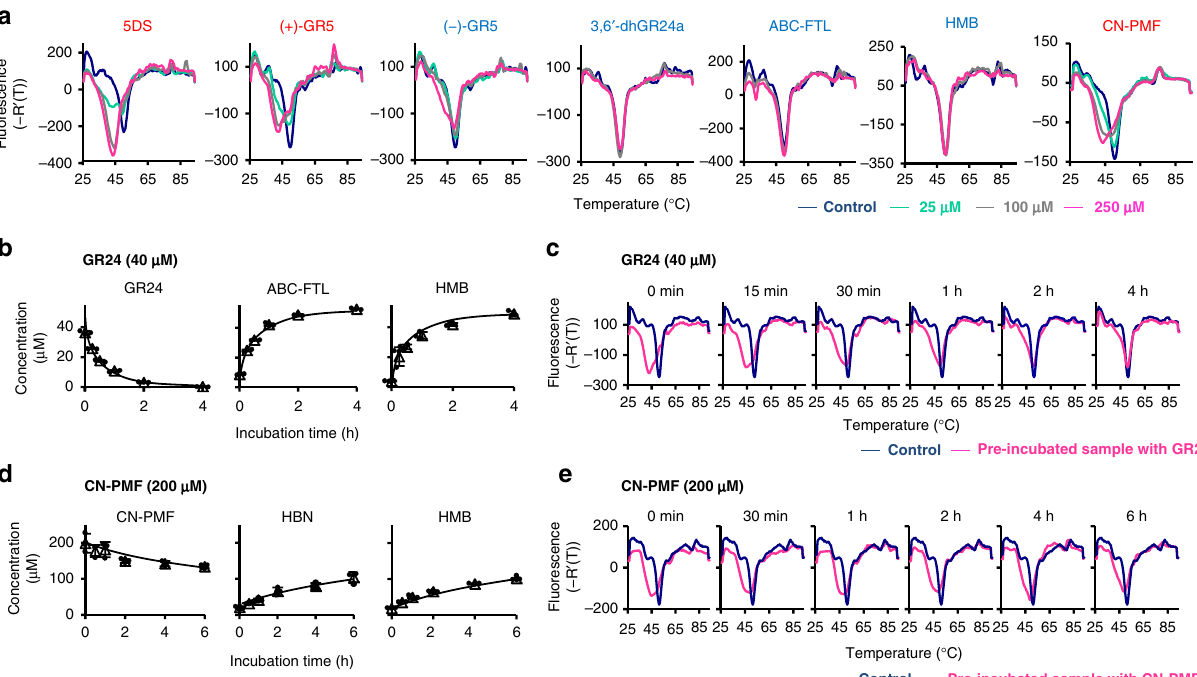
Fig. 2 Evaluation of the AtD14-SL interaction using hydrolysis and DSF assays. a Melting temperature curves of AtD14 in the presence of various SLs and analogs. The names in red and blue denote biologically active and inactive (or weakly active) compounds, respectively. b and d , Monitoring by LC-MS/MS of the AtD14 hydrolysis reaction of GR24 ( b ) and CN-PMF ( d ). HBN; Hydroxybenzenenitrile. Data are the means± SD ( n = 3). c and e Melting temperature curves of AtD14 pre-incubated with GR24 ( c ) and CN-PMF ( e ) for indicated time period. Source data are provided as a Source Data fi